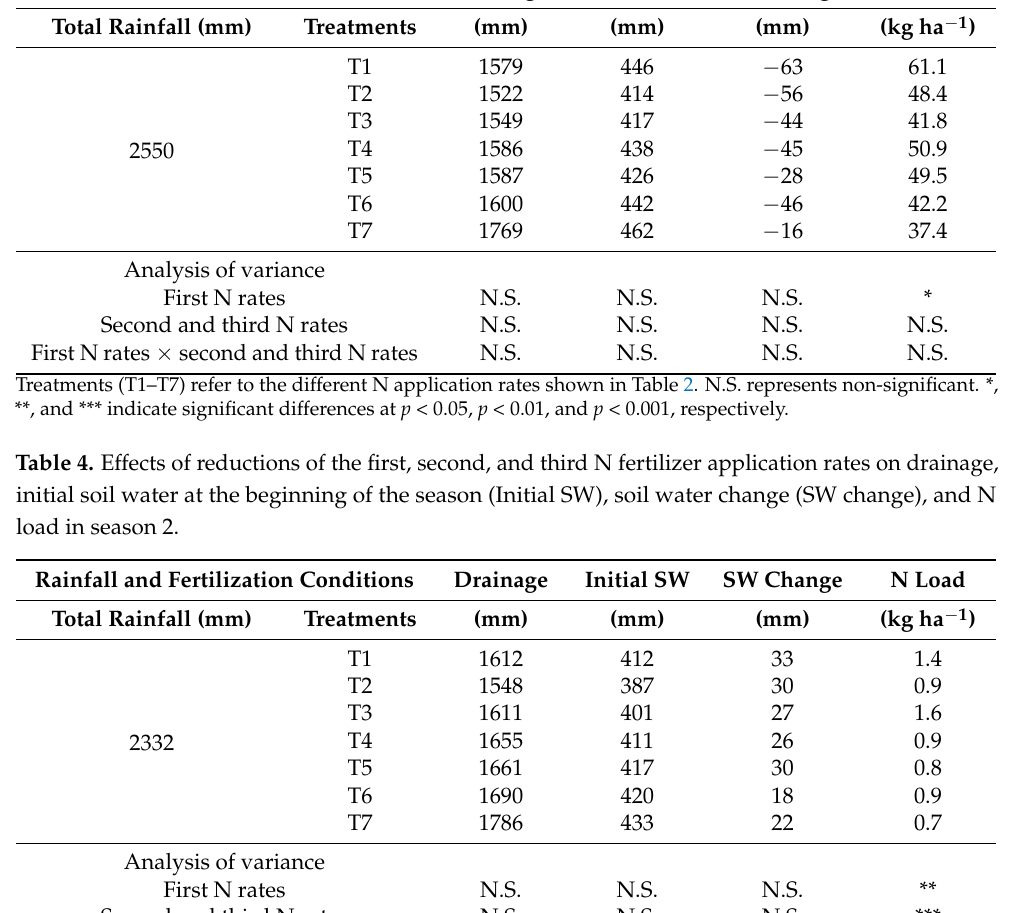
Table 3. Effects of reductions of the first, second, and third N fertilizer application rates on drainage, initial soil water at the beginning of the season (Initial SW), soil water change (SW change), and N load in season 1. Rainfall and Fertilization Conditions Initial SW SW Change